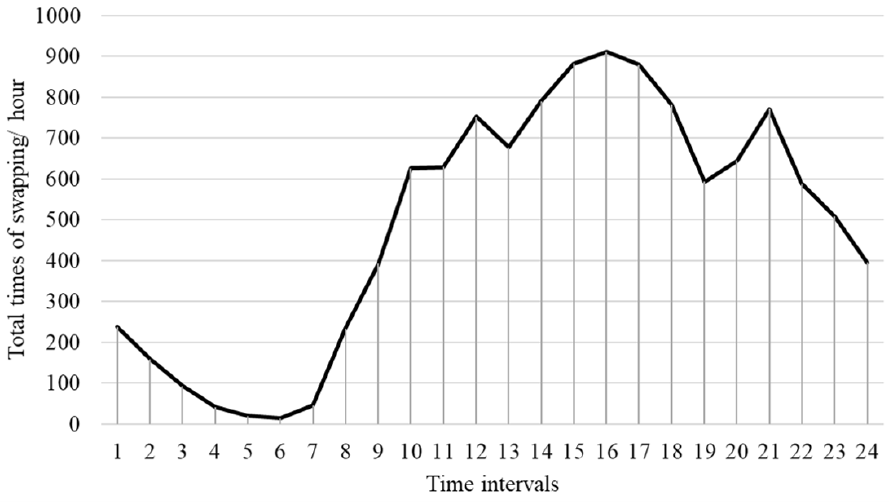
Figure 5. Numbers of users in different stations.